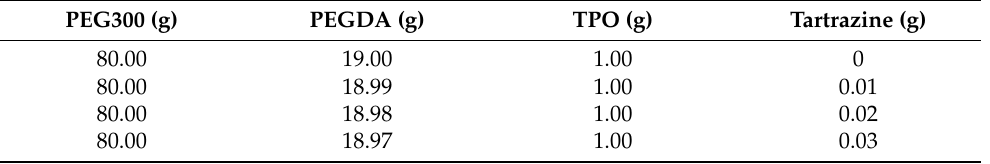
Table 3. The printing formulations with different ratios of photoabsorber (tartrazine).